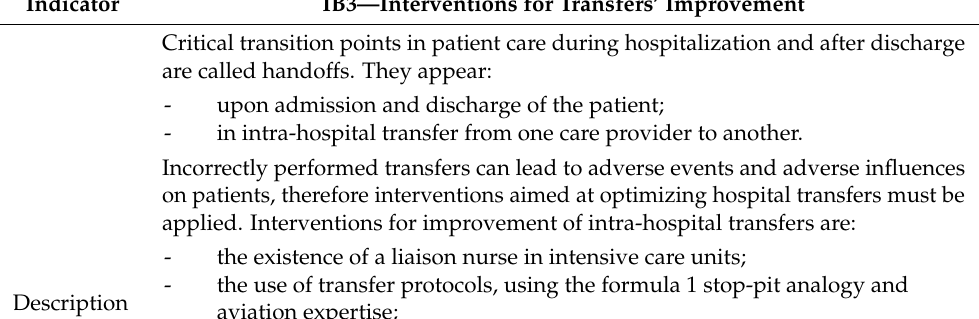
Table A9. The indicator IB3—Interventions for transfers’ improvement. Indicator